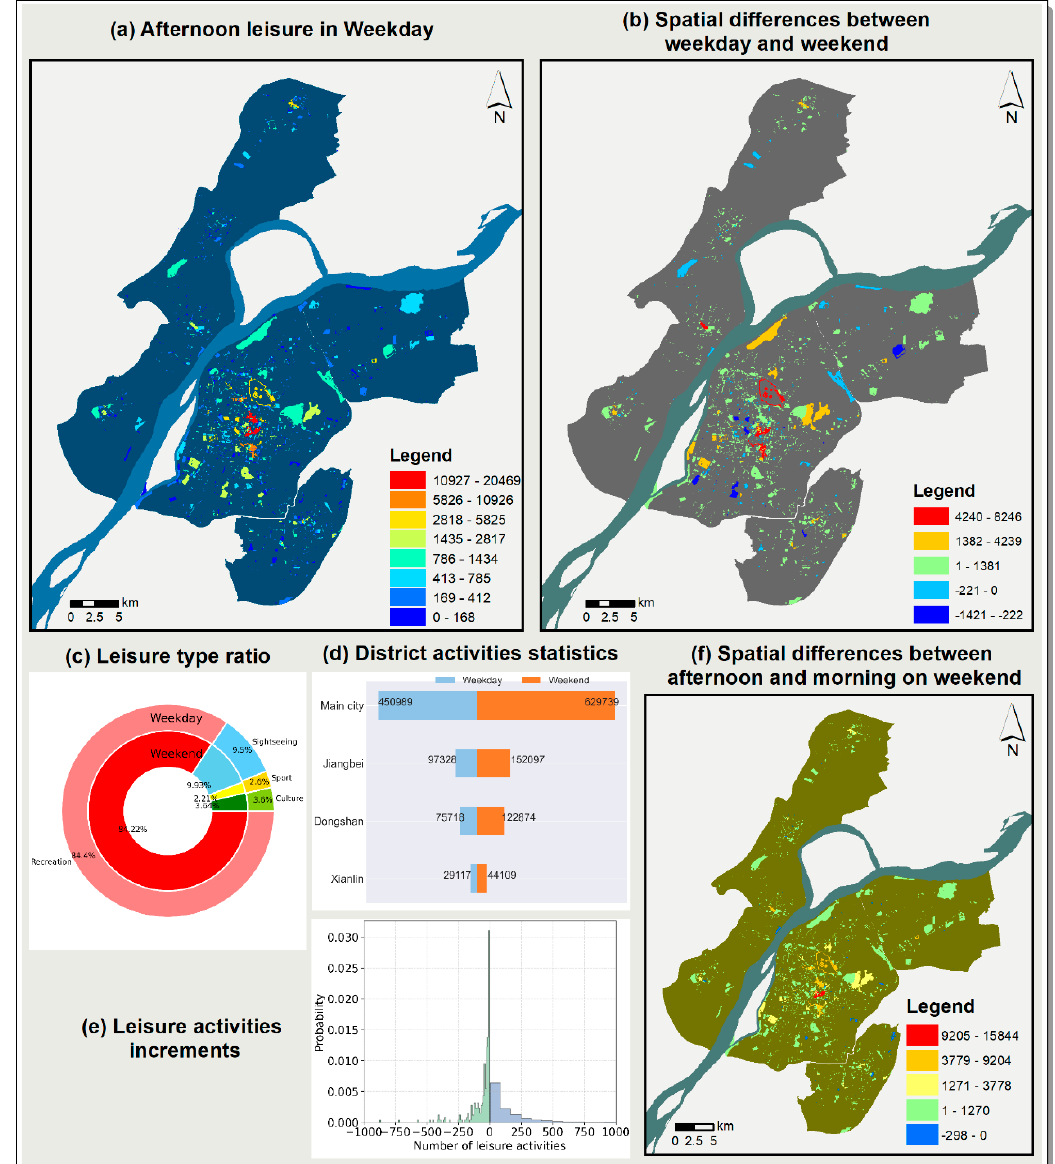
Figure 9. Comparison of afternoon urban leisure activity participants between weekday and weekend.